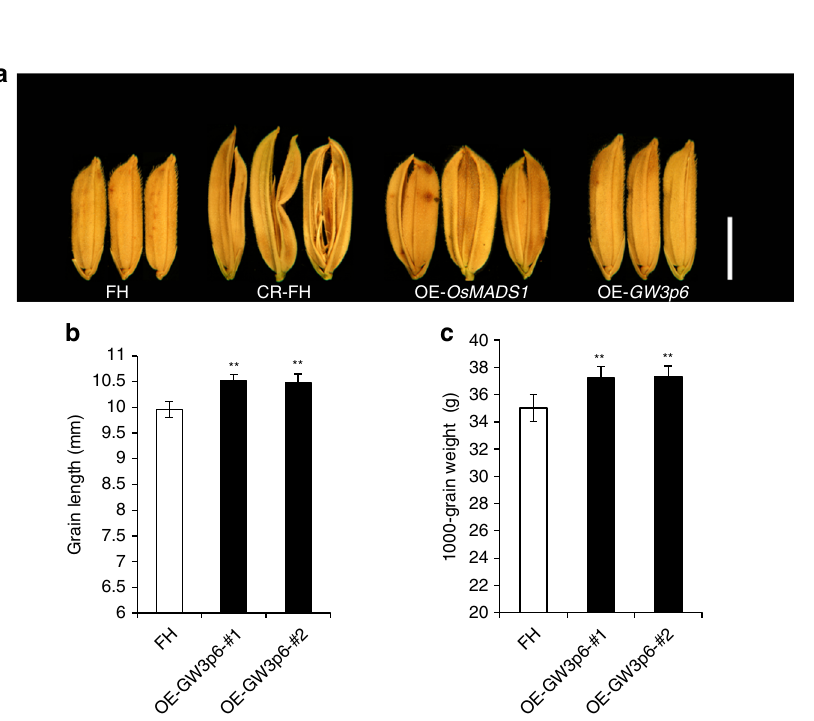
Fig. 2 QTL mapping and map-based cloning of OsMADS1 GW3p6 . a , b Identi fi cation of the genomic region consisting of OsMADS1 GW3p6 via GPS approach. a The p value plot is the result of Ridit analysis for 1000-grain weight before noise-reduction algorithm. The -ln ( p value) plot ( Y axis) is plotted against SNP positions ( X axis) on each of the 12 rice chromosomes. b After the strategy of reducing background noise, the results present as ratio plot. X -axis value is set at a midpoint at each de fi ned genomic interval and Y -axis value corresponds to ratio. c The genotype of chromosome 3 of RIL-79. Black, white and gray bars represent the heterozygous genotype, and homozygous genotypes of GZ and FH respectively. d In the fi ne-scale mapping (lower bar) generated from the analysis of 1,079 segregating individuals, the QTL GW3p6 falls in the heterozygous interval. The numbers below the bar indicate the number of recombinants between GW3p6 and the molecular markers shown. e Genotyping of progeny homozygous for GW3p6 delimited the locus to a ~5.9 Kb genomic region between markers MP99 and MP100. f , h 1000-grain weight and grain length of recombinant F 2 lines of RIL-79 (L1-L4). Data shown as means ± SD, n = 48. Source data are provided as a Source Data fi le. g Schematic diagram depicting the structure of OsMADS1 and OsMADS1 GW3p6 , red letters stand for the nucleotides of OsMADS1 non-homozygous segment. i The sequencing electrophoresis of non-homologous segment between OsMADS1 and OsMADS1 GW3p6 . j The schematic illustration of OsMADS1 functional domains, M represents the MADS domain, I represents the intervening domain, K represents the keratin-like domain, and C represents the C-terminal domain. Source data of Fig. 2f, h are provided in a Source Data fi le